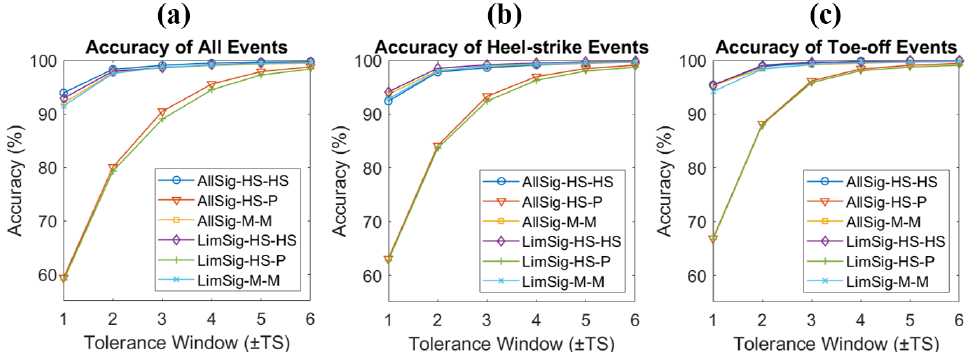
Figure 10. Accuracy plots for ( a ) all events, ( b ) heel-strike events, and ( c ) toe-off events when working with patient data. The plots include results from models trained with all 6 pelvis signals (AllSig) and with limited 4 signals (LimSig). The training and testing include healthy-trained, patient-tested (HS-P), healthy-trained, healthy-tested (HS-HS), and mixed-trained and mixed-tested